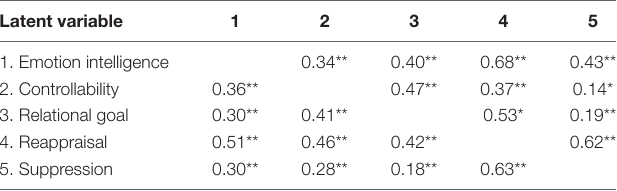
TABLE 3 | Correlations among variables in the measurement model.